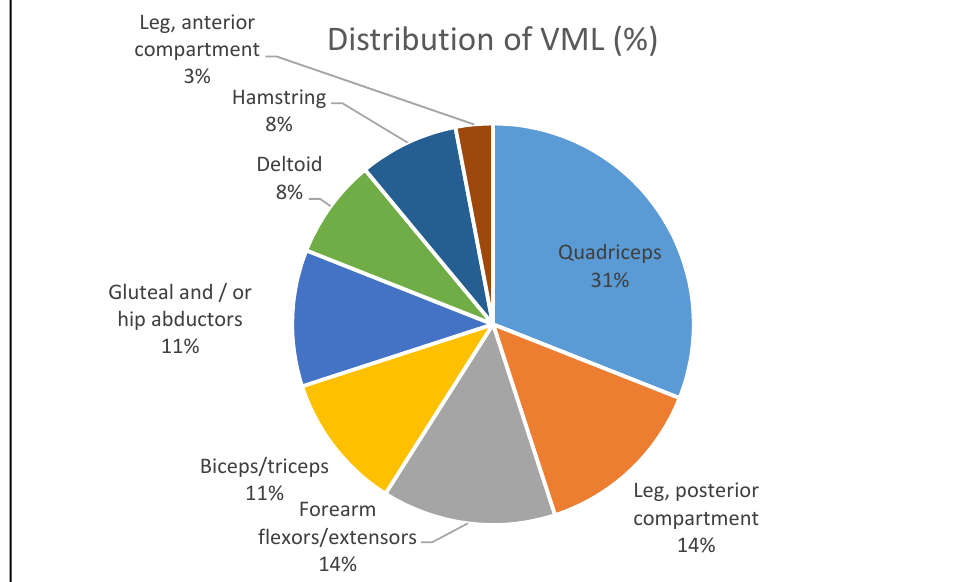
Figure 2. Distribution of VML per body part for a general cohort of 36 patients. The distribution of VML per body part was derived from the literature review [8].